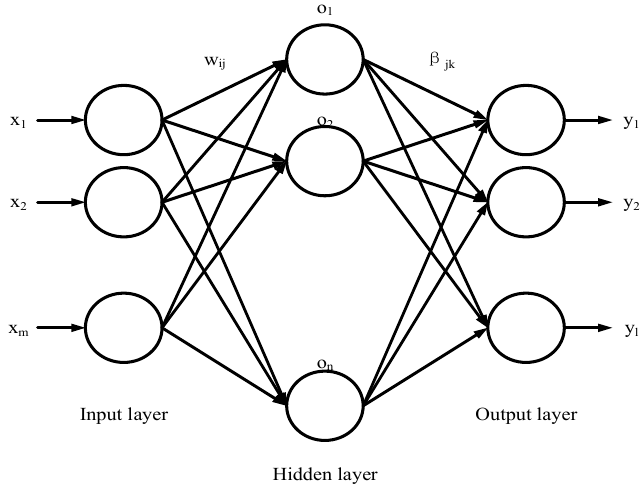
Figure 2. Extreme Learning Machine (ELM) model structure.